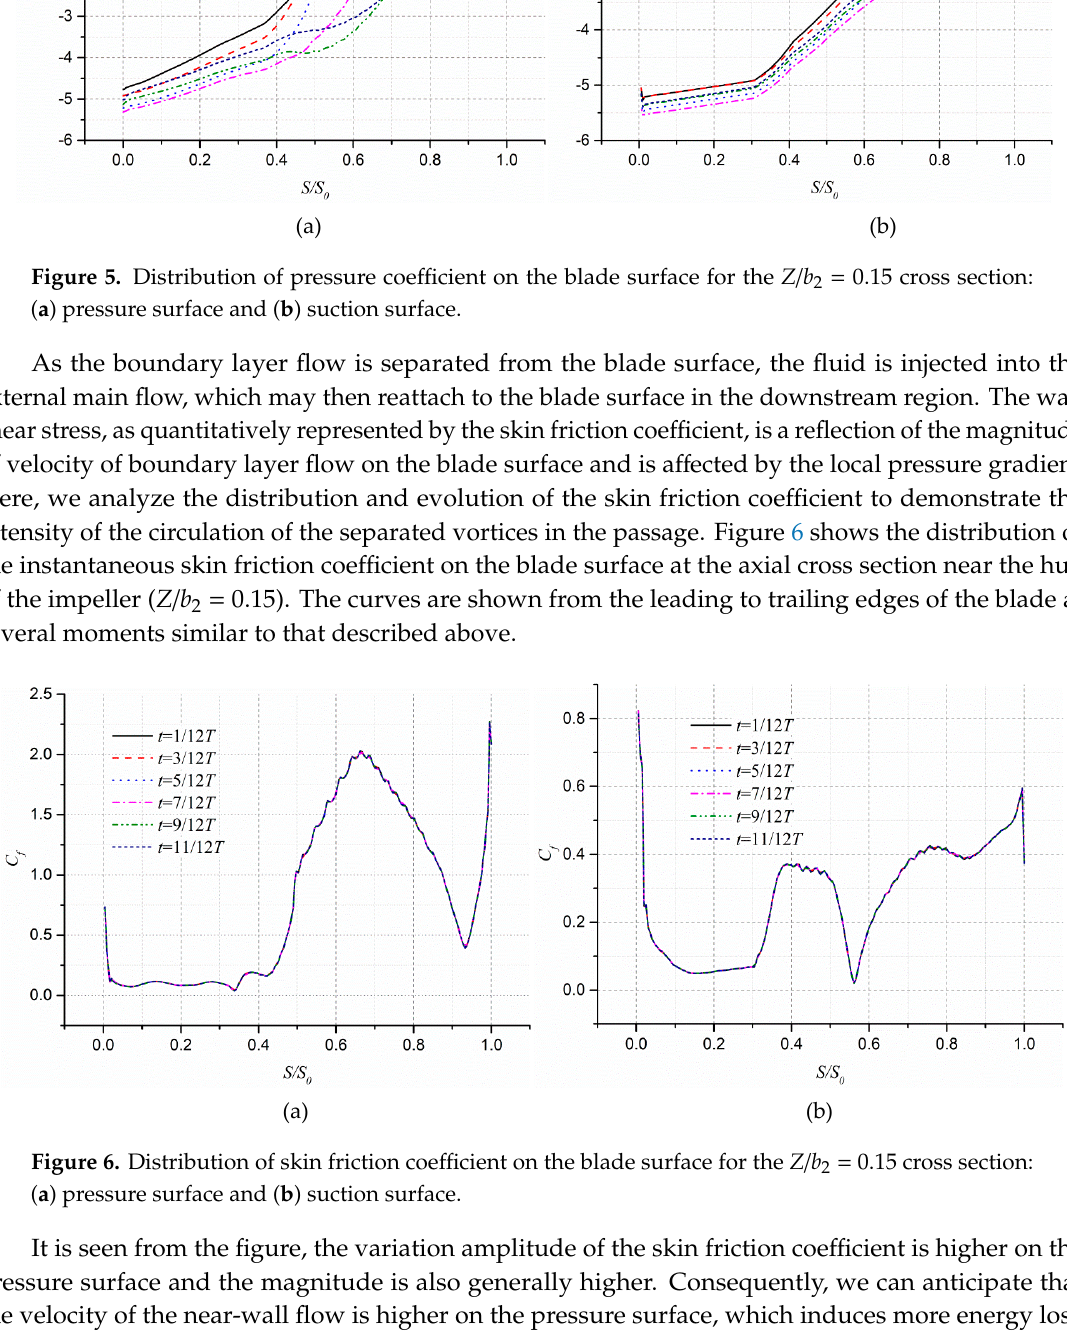
Figure 6. Distribution of skin friction coefficient on the blade surface for the Z / b 2 = 0.15 cross section: ( a ) pressure surface and ( b ) suction surface.